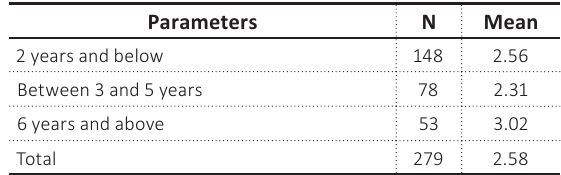
Table 3. Business experience and tax compliance- descriptive extracts